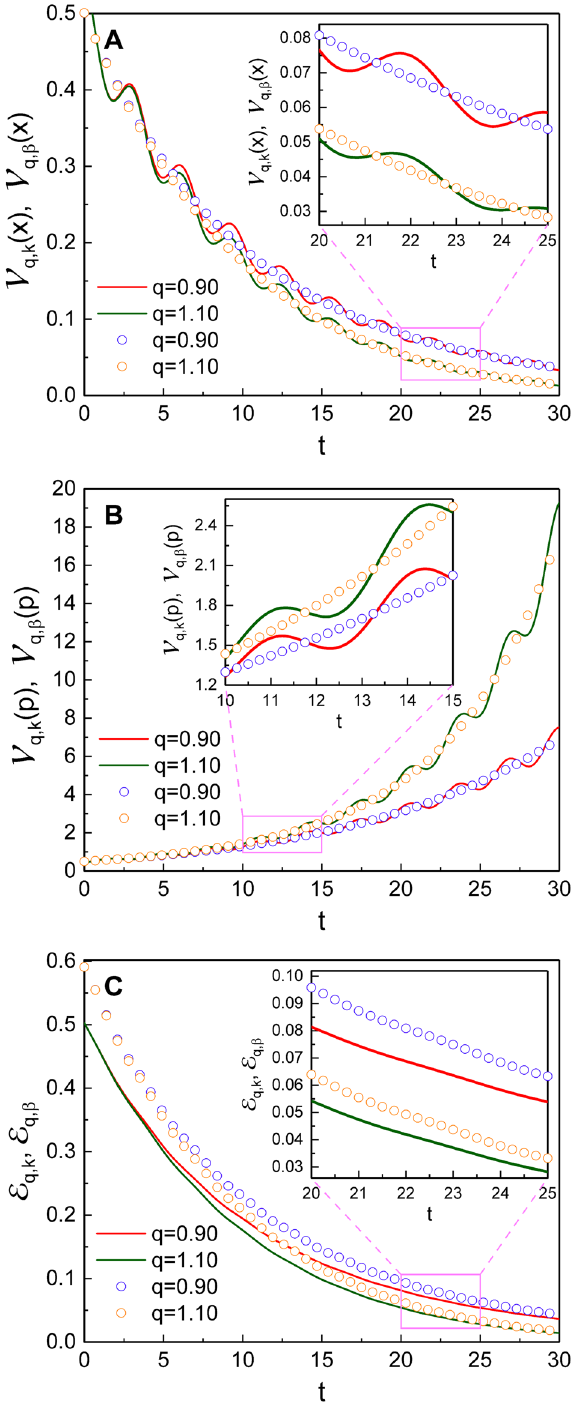
Figure 8. Comparison of our results V q , k ( x ) ( A ), V q , k ( p ) ( B ), and E q , k ( C ) with those in the Glauber coherent state, V q , β ( x ) , V q , β ( p ) , and E q , β , respectively, for two different values of q . Our results are solid curves, whereas the results in the Glauber coherent state are circles. The results associated with the Glauber coherent state, as well as ours, are obtained using DCOIOT. We used ω 1 1 / 4 , and s 0,1 s 0,2 k = = =